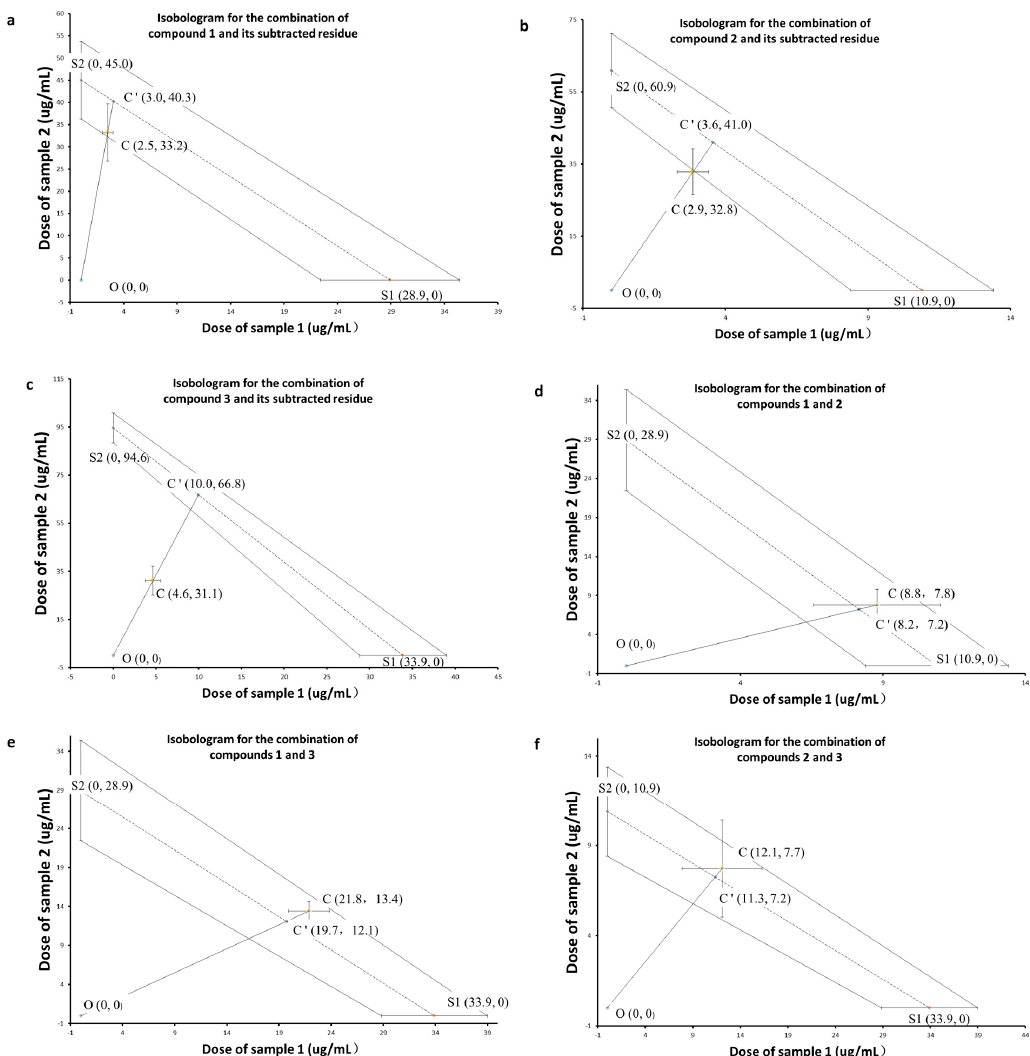
Figure 5. Isobolograms for the combinations of compound 1 and its subtracted residue ( a ), compound 2 and its subtracted residue ( b ), compound 3 and its subtracted residue ( c ), compounds 1 and 2 ( d ), compounds 1 and 3 ( e ), and compounds 2 and 3 ( f ).